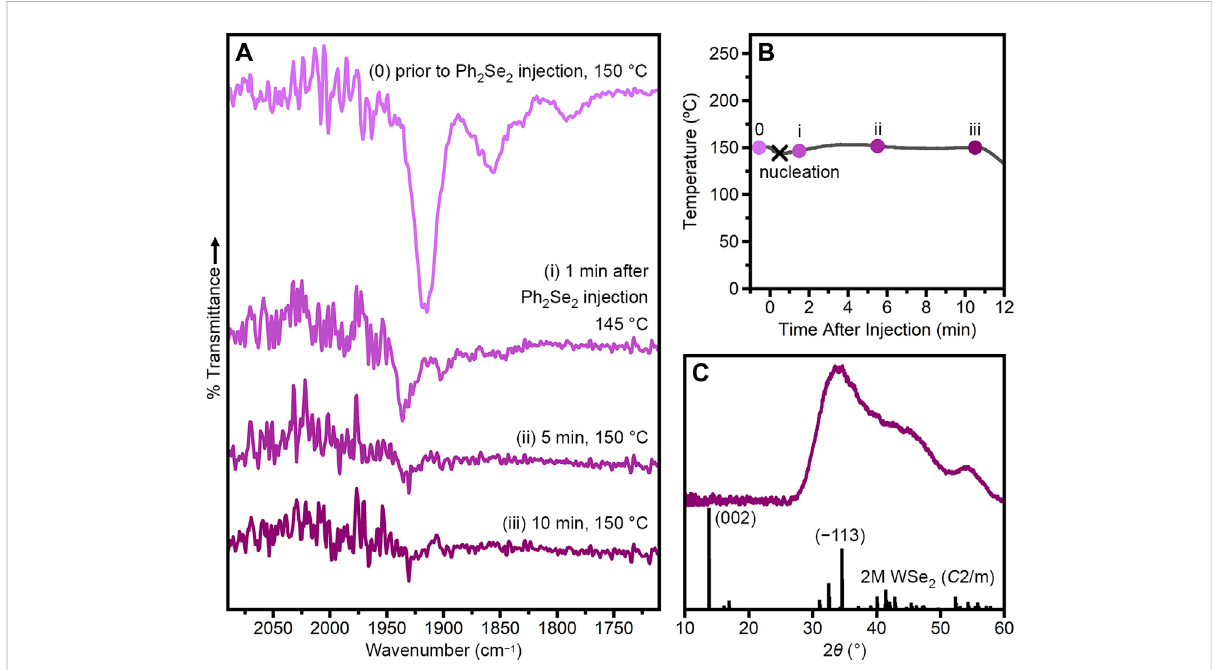
FIGURE 1 Injection of Ph 2 Se 2 into W(CO) 6 + TOPO (TOPO/Se/W = 100/4/1) at 150 ° C. (A) FTIR spectra of aliquots taken prior to Se injection and approximately 1, 5 and 10 min after Se injection. (B) Temperature pro fi le of the reaction with aliquots indicated by circles. The black x indicates the nucleationevent,evidencedbyacolor-changeofthereactionsolution. (C) PowderX-raydiffractionpatternofnanocrystallineproductcomparedto that simulated from single-crystal data for 2M WSe 2 (Fang et al.,